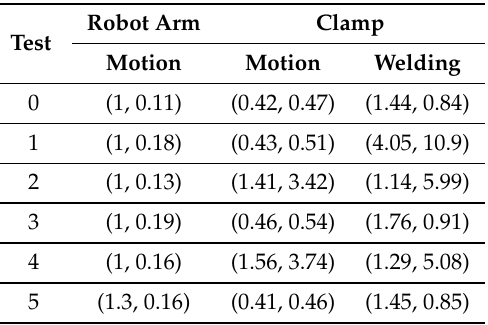
Table 1. Miniterms for a welding unit ( ¯ X , S ) without (test 0) and with deterioration (tests